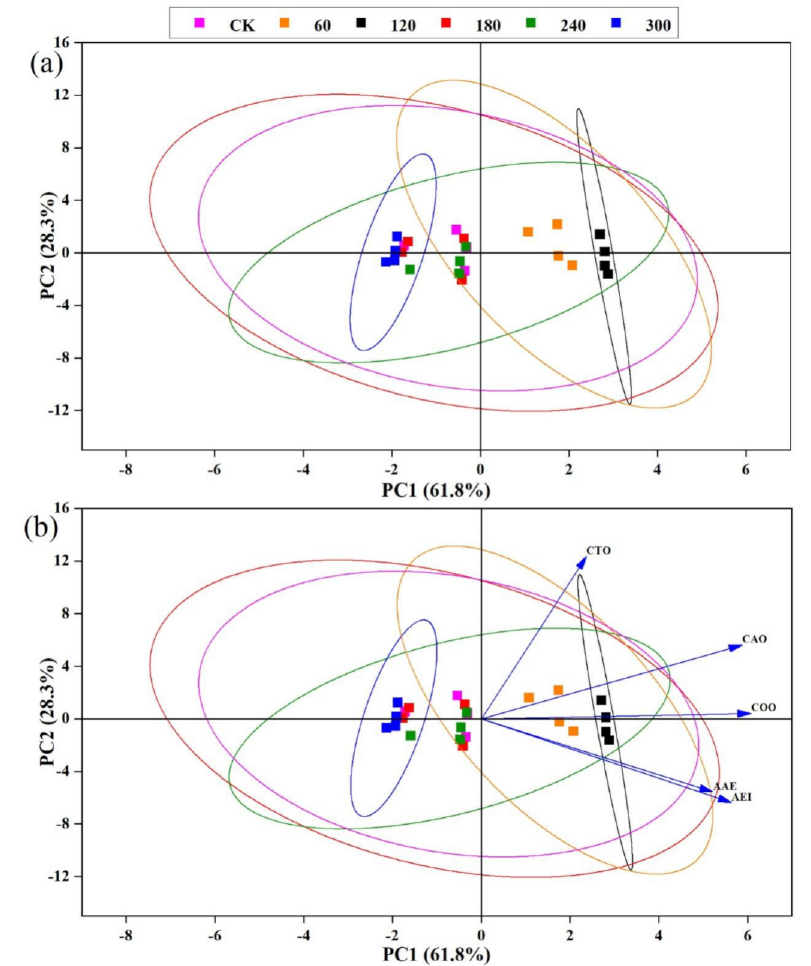
Figure 2. ( a ) PCA plot describing the variation in the taste fingerprints of HVCP-treated EWP; ( b ) Loading plot describing the distribution of taste fingerprints across various HVCP treatment on the EWP.CK: Control; PC1: Principal component 1; PC2: Principal component 2; AAE: Umami; CTO: Saltiness; CAO: Sourness; COO: Bitterness and AEI: